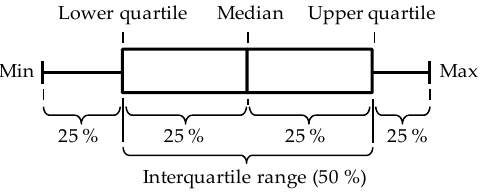
Figure 2. Notes on the presentation of results in form of a box plot.